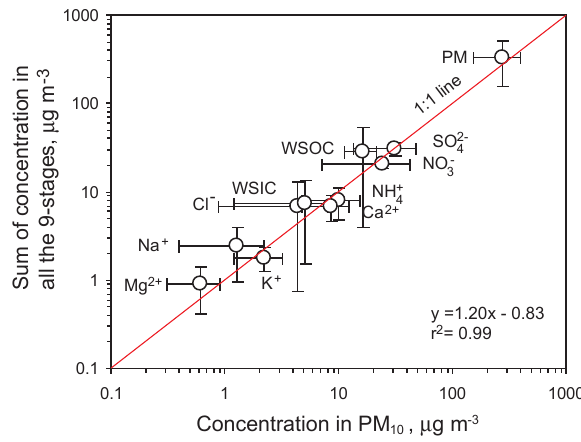
Fig. 2. Intercomparison of components measured by the PM 10 sam-